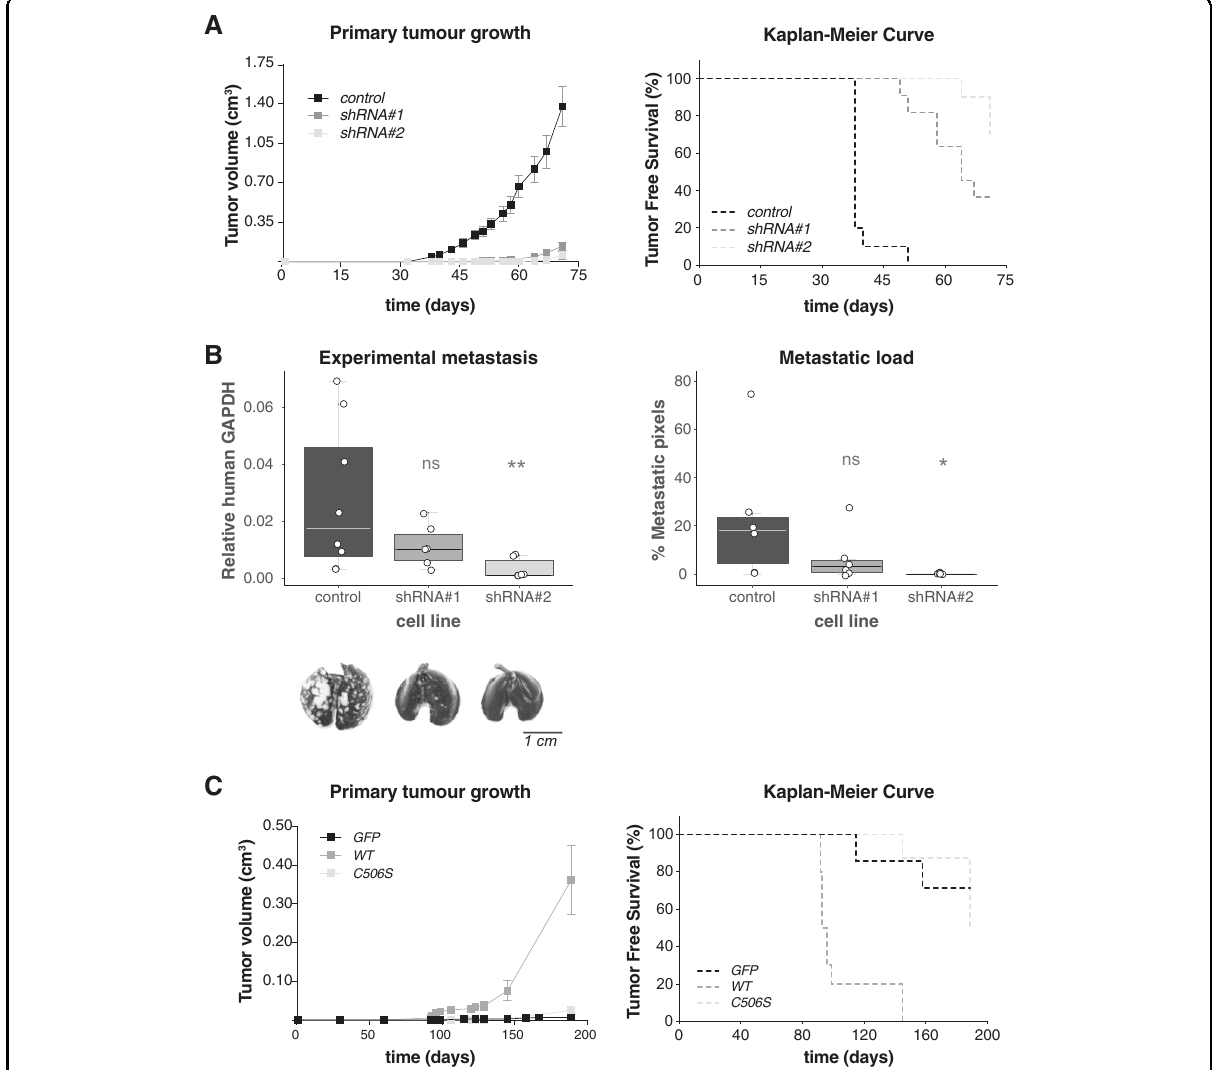
Fig. 5 Analysis of USP19 expression relevance using mice models. ( A ) Downregulation of USP19 attenuates tumorigenicity in vivo: Control or USP19-silenced MDAMB231 cells were subcutaneously inoculated into the mammary fat pads of female NOD/SCID mice and tumor growth monitored every 2 – 3 days. Left: tumor volume was calculated at the indicated time points (results show mean value ± S.E.); right: Kaplan – Meier curves were built for tumor-free survival (TFS) over time ( n ≥ 10, Log-Rank (Mantel-Cox) test, shRNA#1 p < 0.0001 and shRNA#2 p < 0.0001). B Silencing effects of USP19 on experimental metastasis assays: NOD/SCID male mice were inoculated with MDAMB231 USP19-silenced cells through tail vein injection and after 2 months, lungs were harvested. Top left: metastatic foci were estimated by qPCR human DNA quanti fi cation ( n ≥ 6, Kruskal – Wallis, Dunn ’ s multiple comparison test. shRNA#1 p = 0.9950 and shRNA#2 p = 0.0032). Bottom left: representative lung images stained with Indian ink at the end of the experiment are shown. Scale bar = 1 cm. Right: metastatic load quanti fi cation was performed by evaluating lung Hematoxylin & Eosin- stained slides. We used a lesion-based analysis of percent of metastatic pixels to compare the differences in metastatic load produced on the lungs by the MDAMB231 cell lines ( n = 6, Kruskal – Wallis, Dunn ’ s multiple comparison test. shRNA#1 p > 0.9999 and shRNA#2 p = 0.0299). C USP19 catalytic activity is needed for tumorigenicity in vivo: control, WT or C506S mutant versions of USP19 overexpressing MCF7 cells were subcutaneously inoculated into the mammary fat pads of female NOD/SCID mice. Left: tumor volume was calculated at the indicated time points (results show mean value ± S.E.); right: Kaplan – Meier curves were built for tumor-free survival (TFS) over time ( n ≥ 7, Log-Rank (Mantel-Cox) test, WT p < 0.0001, and C506S p =